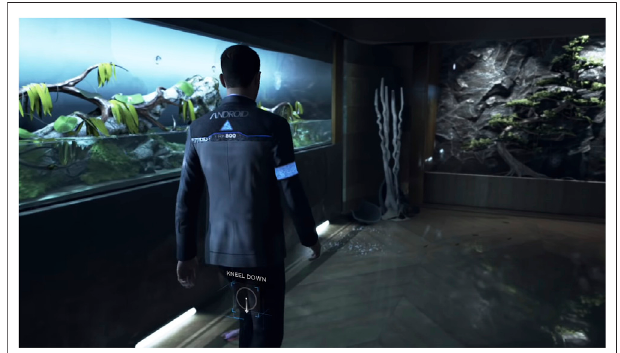
FIGURE 1 | Connor stands in the corridor where the fi sh scene takes place. On its back it is possible to read “ ANDROID ” . The broken fi sh tank is visible on the wall on the left. On the fl oor lies the fi sh. An overlayed interface signals the possibility to kneel down near the fi sh by moving the right analogue stick towards the player ’ s body (down). Screenshot from Detroit: Become Human (Quantic Dream 2018) for PlayStation 4.